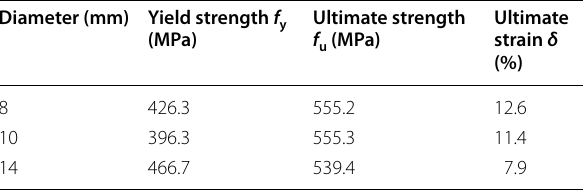
n s for each test wall. The normalised concrete tensile stress n c is used to quantify the degree of axial tensile force which is less than crack strength, which is taken as n c N t /( A c A s E s / E c ) f t , where N t denotes the axial ten- = + sile force of the wall, A c denotes the cross-sectional area